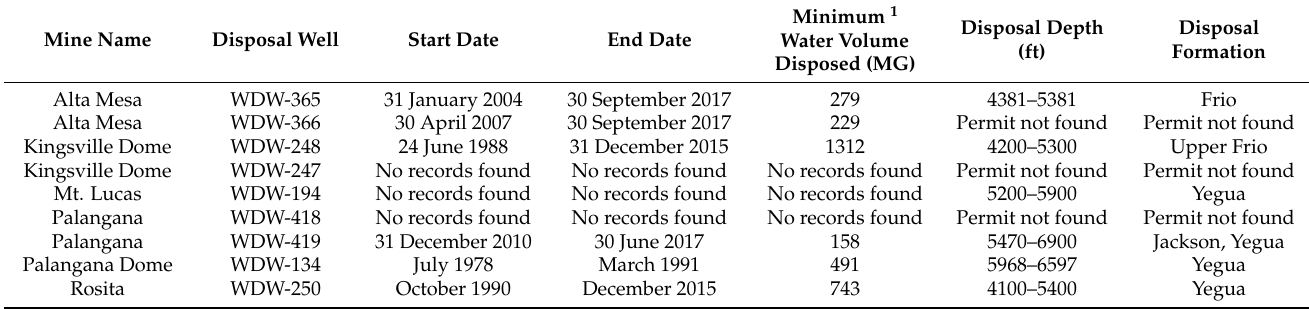
Table A5. Minimum Volumes of Wastewater Injected into Class I Deep Disposal Wells.